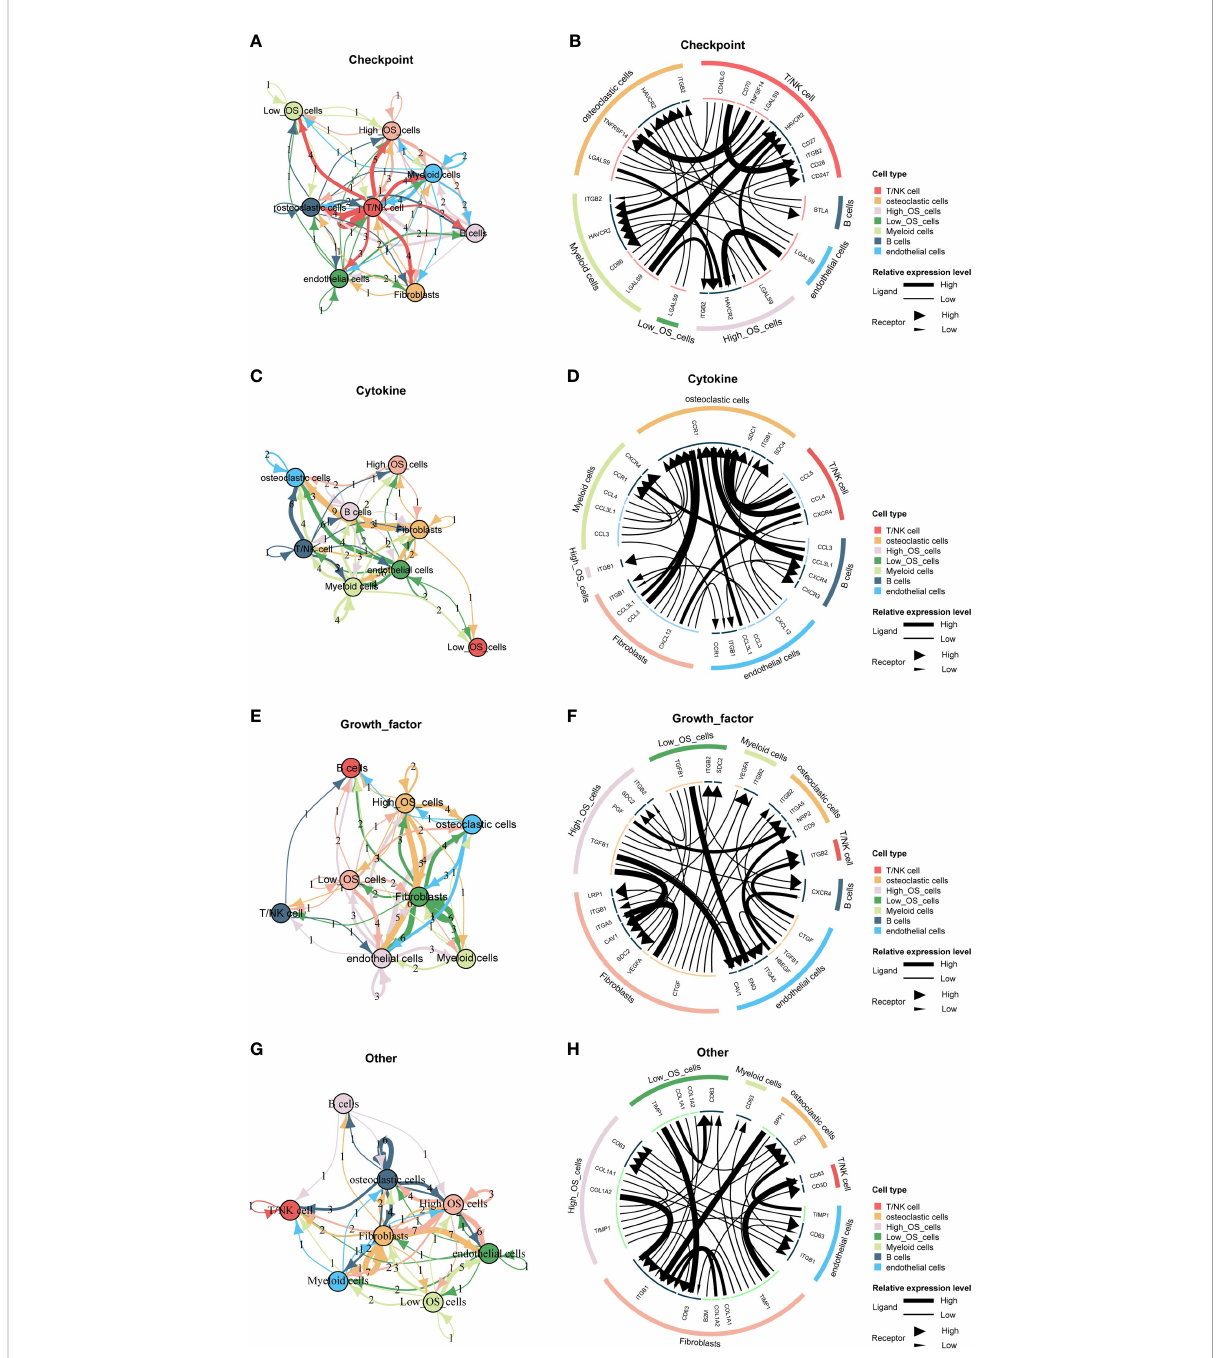
FIGURE 6 Cell communication pattern of the mitochondria-related signature. (A) Different cellular signaling pathways regarding checkpoints between two mitochondria-related signature score groups of osteosarcoma cells and microenvironment cells. (B) Cell communication pattern regarding checkpoints between two mitochondria-related signature score groups of osteosarcoma cells and microenvironment cells. (C) Different cellular signaling pathways regarding cytokine between two mitochondria-related signature score groups of osteosarcoma cells and microenvironment cells. (D) Cell communication pattern regarding cytokine between two mitochondria-related signature score groups of osteosarcoma cells and microenvironment cells. (E) Different cellular signaling pathways regarding growth factor between two mitochondria-related signature score groups of osteosarcoma cells and microenvironment cells. (F) Cell communication pattern regarding growth factor between two mitochondria- related signature score groups of osteosarcoma cells and microenvironment cells. (G) Different cellular signaling pathways regarding other between two mitochondria-related signature score groups of osteosarcoma cells and microenvironment cells. (H) Cell communication pattern regarding other between two mitochondria-related signature score groups of osteosarcoma cells and microenvironment